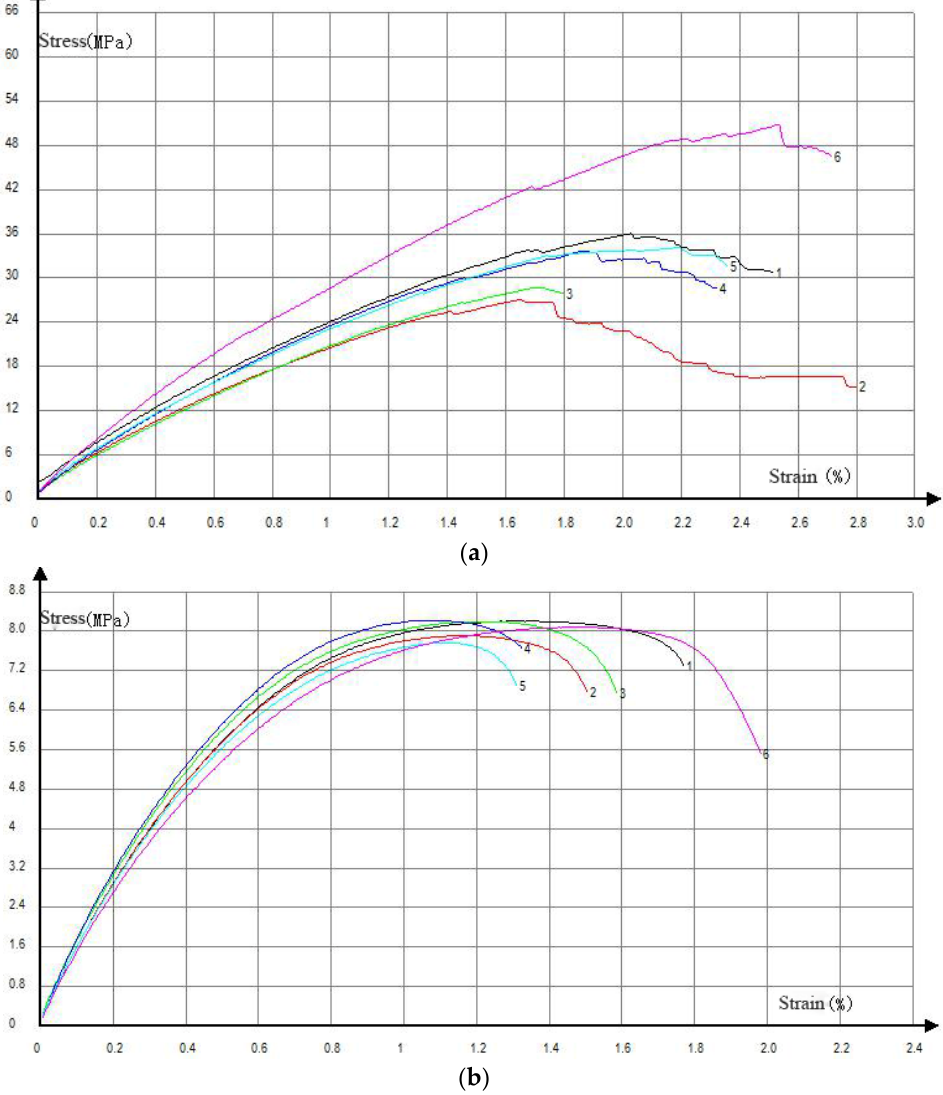
Figure 9. Tensile stress-strain curves of specimen 1 to 6 of hot pressed ( a ) and extruded ( b ) straw/LLDPE composite.